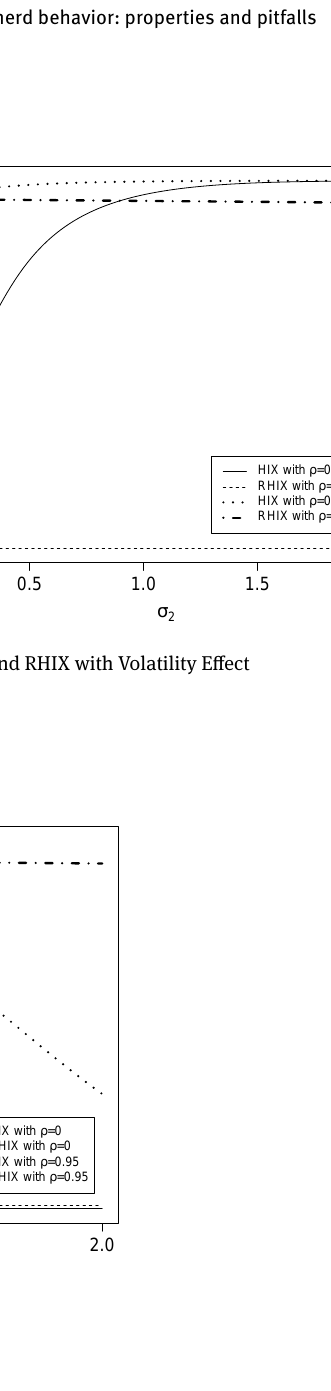
CIX is significantly decreasing as the volatility of one stock price is increasing. This implies that correlation does not properly represent the degree of